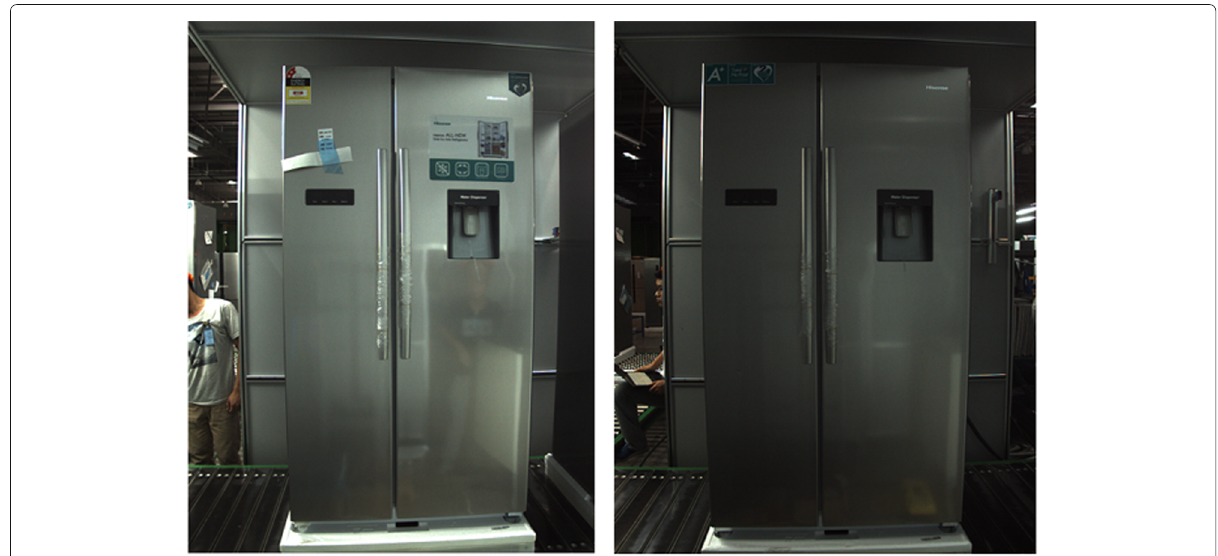
Fig. 1 The dense clutter in the front-view images of refrigerator